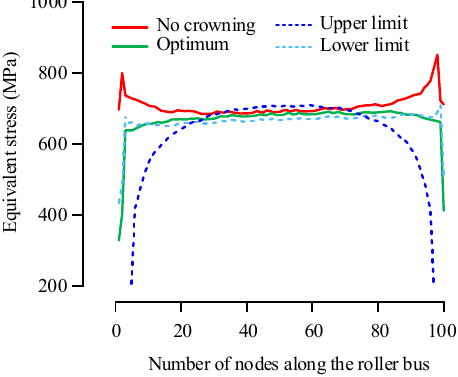
Figure 28. Stress distribution along the roller profile before and after being crowned. When cof is equal to 0, i.e., when the roller is not crowned, the stress distribution along the roller profile appears as obvious edge stress concentration, and the maximum stress of the roller profile is 851.52 MPa. When cof is equal to cof opti, that is when the roller is optimally crowned, the stress distribution along the roller profile is uniform without obvious stress concentration, the maximum stress is 693.07 MPa, and the maximum stress of the roller profile is reduced by 18.6% compared with the uncrowned. When cof is equal to cof d or cof u , the maximum stress of the roller profile is 710 MPa, and the maximum stress of the roller profile of the roller is reduced by 16.6% compared with the uncrowned.